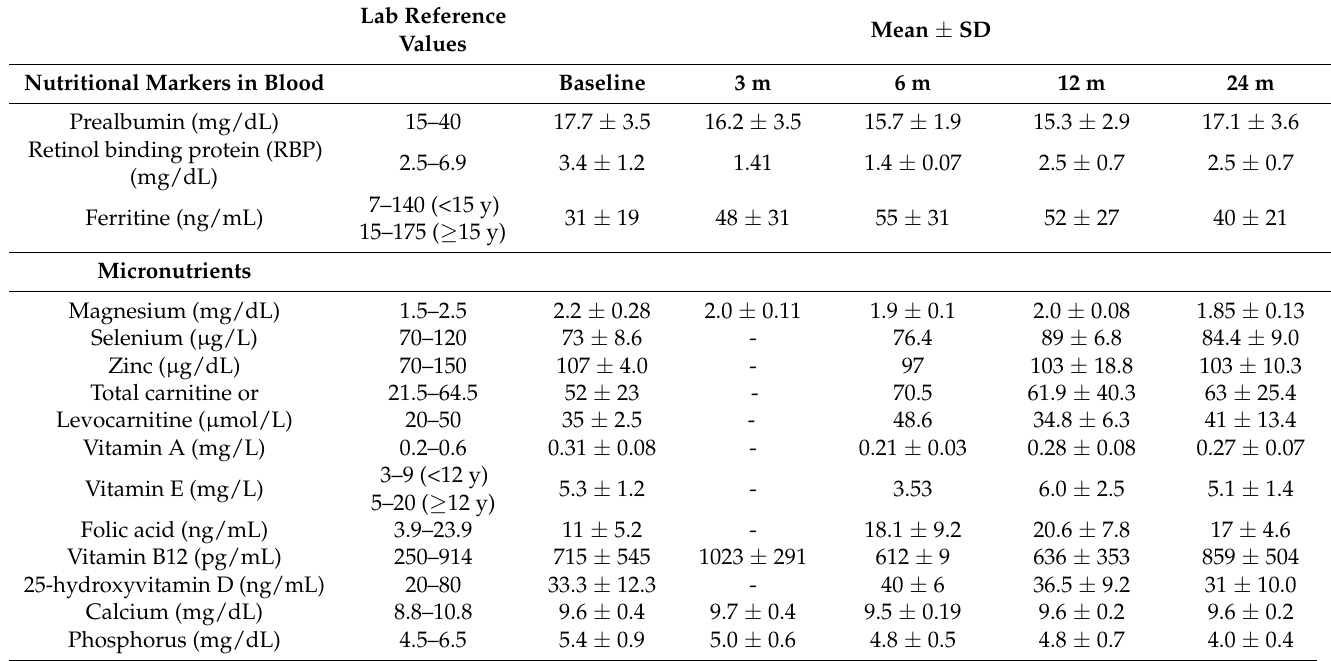
Table 3. Evolution of nutritional markers and micronutrients. Lab